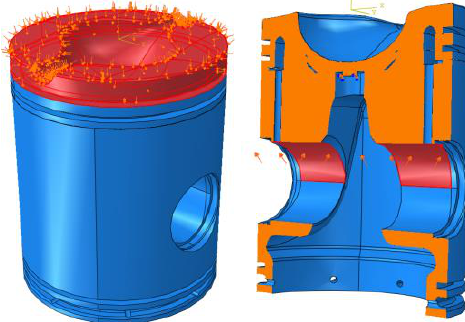
Fig. 4. Surfaces for which the following conditions were given: combus- tion pressure (left), reaction pressure from the piston pin (right) The material properties adopted for calculations are pre-